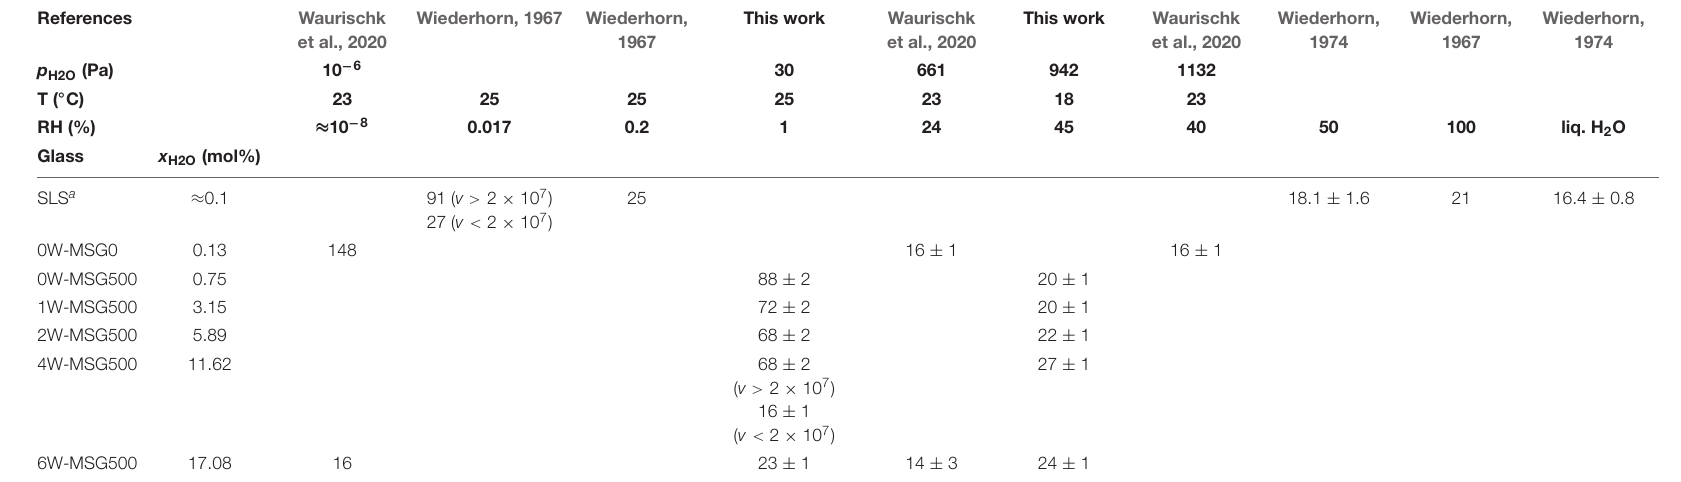
TABLE 3 | Crack growth exponent n of the equation v av = A ( K I / χ B ) n and v = AK I n of Vickers induced and DCB cracks in soda-lime silicate glasses,